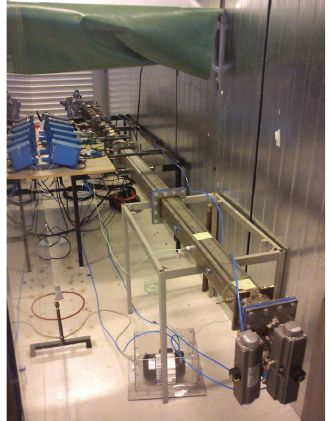
Figure 3: Picture of the experimental